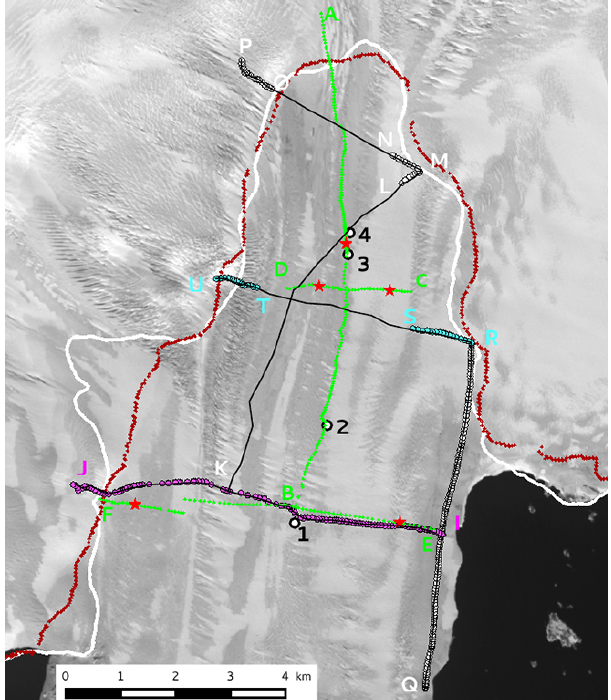
Figure 4. Summary map of field activities carried out on the surface of the Astrolabe Glacier superimposed on an Advanced Spaceborne Thermal Emission and Refection Radiometer (ASTER) image. The thin black line outlines the ground radar profiles acquired and the overlapping coloured dots indicate where the ice bottom echo was detectable and a depth could be inferred. Green dots represent each of the points measured twice by kinematic GPS in order to detect the difference in ice surface elevation between low and high tides and the red stars indicate the resulting “GPS control points” (see Sect. 4.1). Points 1 to 4 indicate where surface elevation was con- tinuously monitored by GPS for several days (Sect. 4.2.2). Lastly, the white and brown lines are the grounding lines proposed by Bind- schadler et al. (2011) and Scambos et al. (2007) respectively.